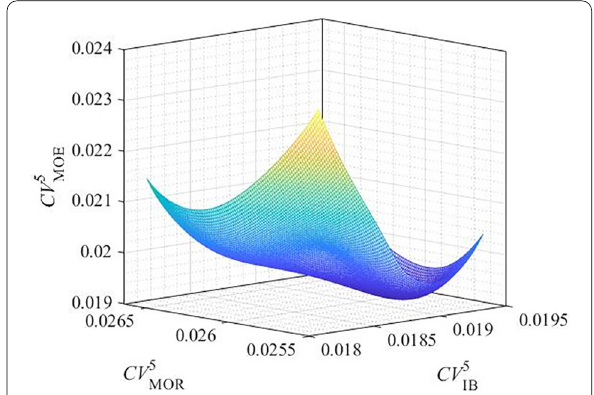
Fig. 4 Pareto fronts of CV 5 MOE , CV 5 MOR , and CV 5 IB